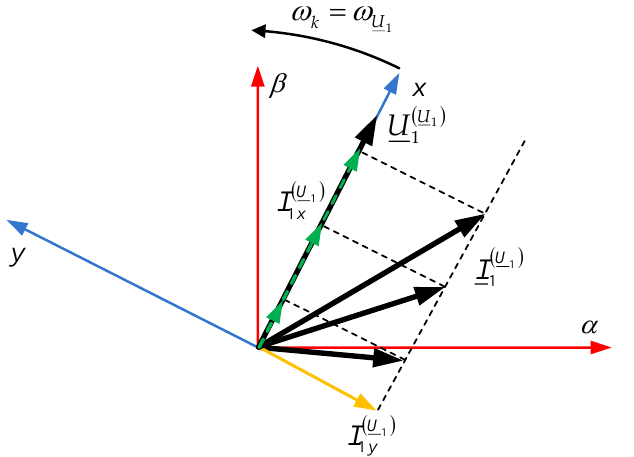
Figure 2. The stator voltage and current space vectors under various IM load conditions in the coordinate system oriented with respect to the stator voltage space vector.